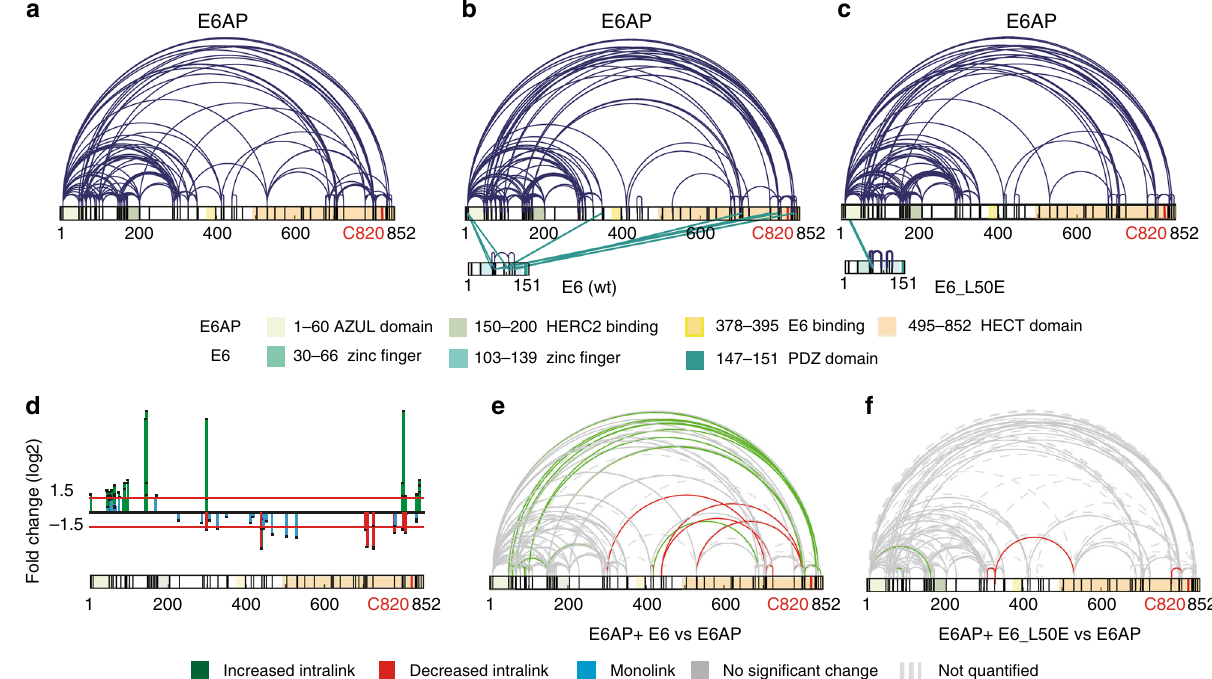
Fig. 1 Binding of E6 induces a conformational rearrangement of E6AP. Pattern of intralink distribution within E6AP as determined by XL-MS a in the absence of the HPV E6 oncoprotein, b with wild-type (wt) E6, and c with the E6_L50E mutant, which does not bind to E6AP. Intralinks are shown in dark blue and interlinks in dark green; lysine residues are shown in black. The catalytic cysteine residue of E6AP at position 820 is indicated in red. The AZUL domain, HERC2 and E6 binding sites, and the HECT domain are indicated in pastel green, sulfur yellow and sand yellow, respectively. Regions in E6 representing zinc fi nger motifs are colored in pastel turquoise and the PDZ binding domain is colored in mint turquoise. d Changes in crosslink abundance for each unique crosslinking site with E6AP upon binding of wild-type E6 were used to calibrate and normalize the quantitative XL-MS (q-XL-MS) data. Changes are expressed as fold change (log 2 ratio of abundance of E6AP in the presence of E6 versus abundance of E6AP alone). The horizontal red line indicates the signi fi cance threshold (fold change: log2 ratio ≤ ±1.5). Changes in monolinks are shown in blue and signi fi cantly changed intralinks within E6AP are shown in green (relative increase upon binding of E6) and red (relative decrease upon binding of E6), respectively. The p values for each quanti fi ed link are indicated. e Applying q-XL-MS to recombinantly expressed E6AP in the presence or absence of wild-type E6 identi fi es numerous high- con fi dence crosslinks. Only crosslinks that could be reproducibly quanti fi ed from the pool of identi fi ed high-con fi dence crosslinks in both samples (with and without E6) ( n = 3, each sample analyzed additionally as technical duplicate) and consistently over 3 different biological replicates are shown (violation = 0; p value ≤ 0.01 (two-sided t -test)). Depicted in green are crosslinks that were found to be signi fi cantly upregulated upon binding of E6, while downregulated links are shown in red (de fi ned as a log2 change of ≥ ±1.5). Crosslinks with no signi fi cant change are depicted in gray while links that could not be reliably quanti fi ed are show with a dashed line in light gray. f Quanti fi cation of the change in abundance of identi fi ed intralinks within E6AP, when incubated with the binding-de fi cient E6_L50E mutant vs. E6AP alone, reveals no signi fi cant up- or downregulated links. For monolinks, see